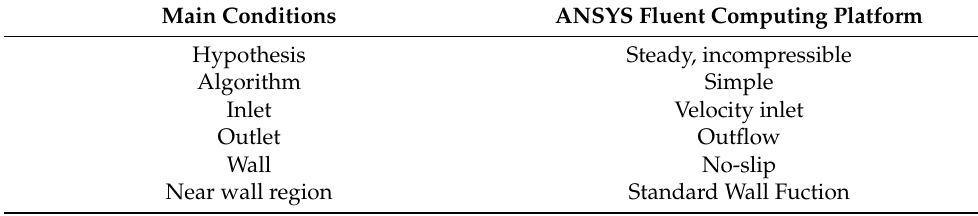
Table 1. Boundary